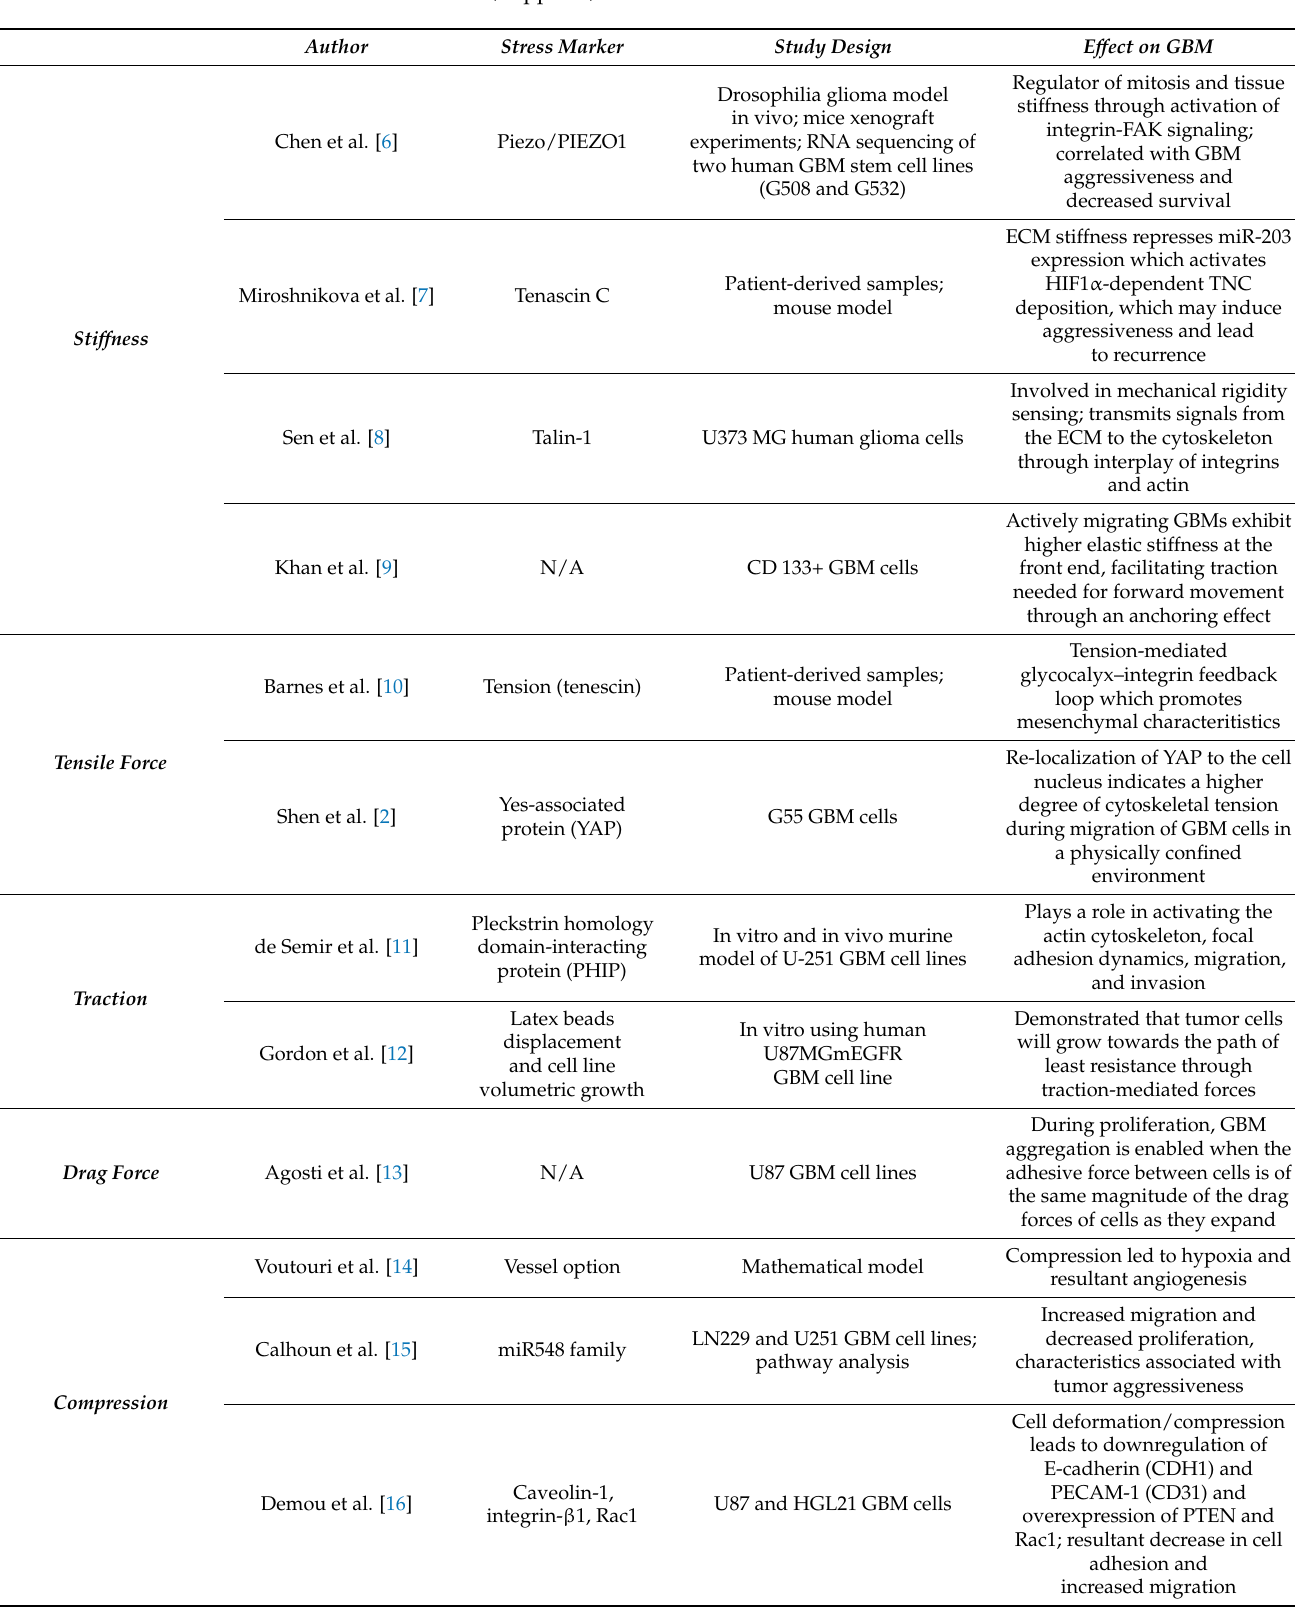
Table 1. External/Applied/Mechanic Forces in